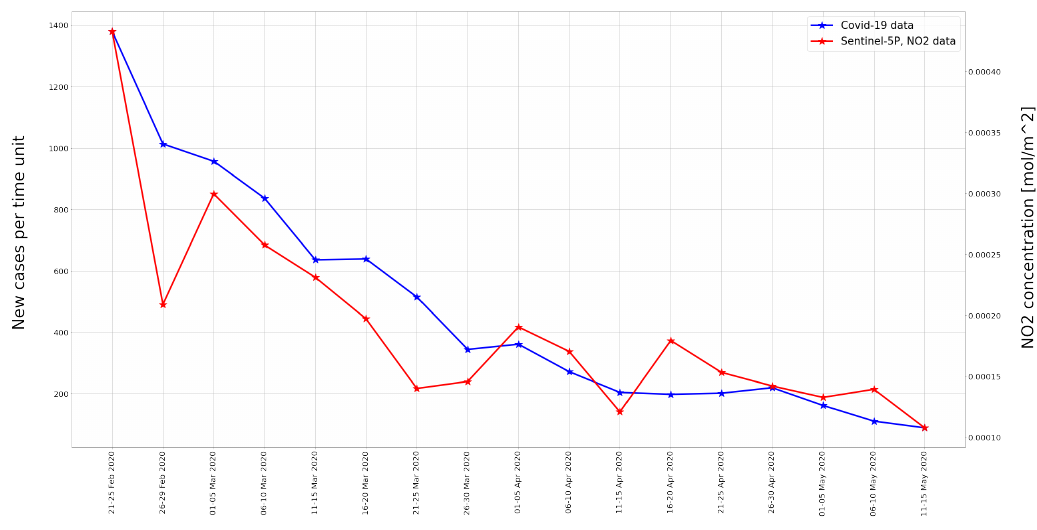
Figure 17. New daily cases vs. average concentration of NO 2 in Lombardy.